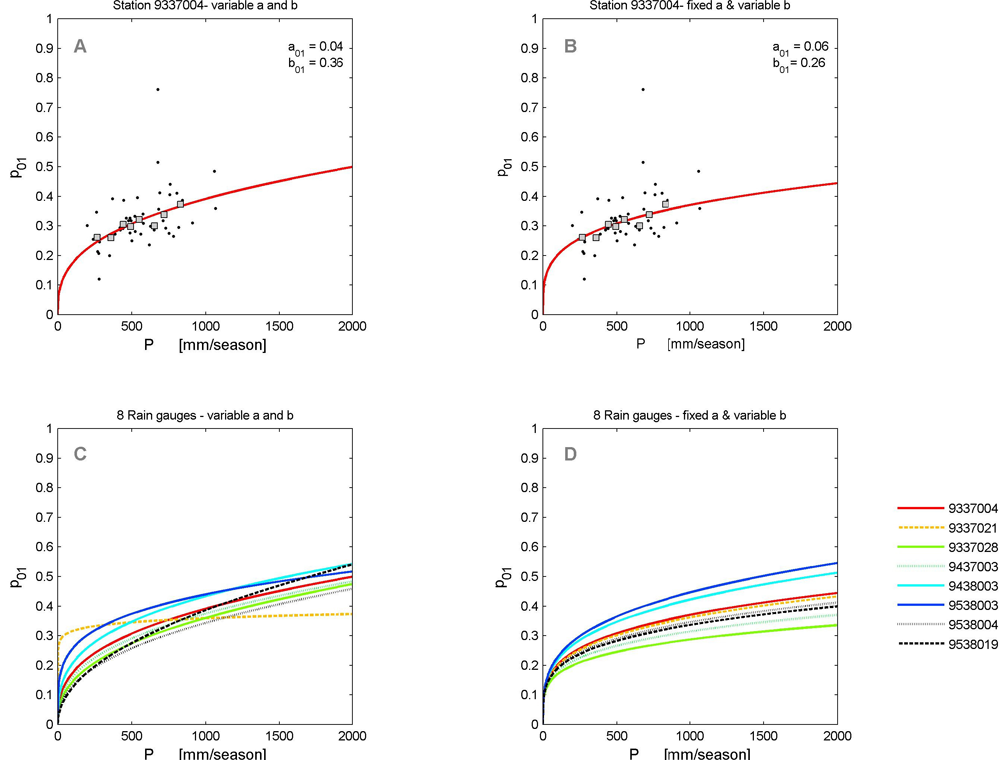
Fig. 3. Transition probabilities p 01 vs. precipitation in Masika season. Scatter plot of one rain gauge 9337004 with (A) variable a and b , (B) fixed a and variable b . Dots represent individual seasons, and squares represent the median value per rainfall class. Plot of all eight rain gauges of the Pangani basin with (C) variable a and b , (D) fixed a and variable b . R 2 values are listed in Table